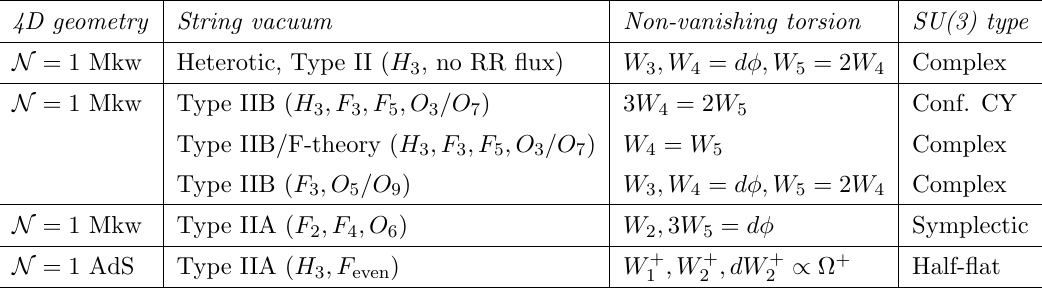
Table 3 . An overview of SU(3) vacua of string theory where H 3 denotes the NS (cid:13)ux, F p the RR p -form (cid:13)ux, O p the orientifold planes and (cid:30) the dilaton. The third column lists necessary SUSY constraints on the torsion (necessary and su(cid:14)cient for the type IIA AdS vacua). The table summarises information from refs. [36,